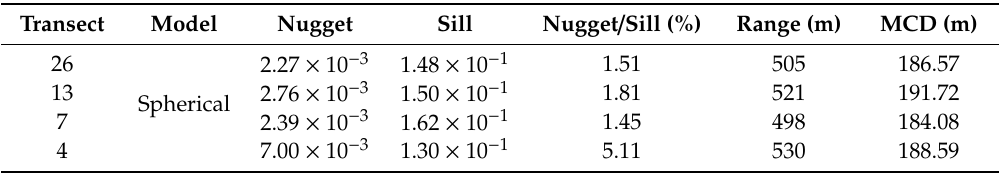
Table 3. Best fit variogram parameters for the natural logarithm of soil ECa datasets for the di ff erent numbers of transect